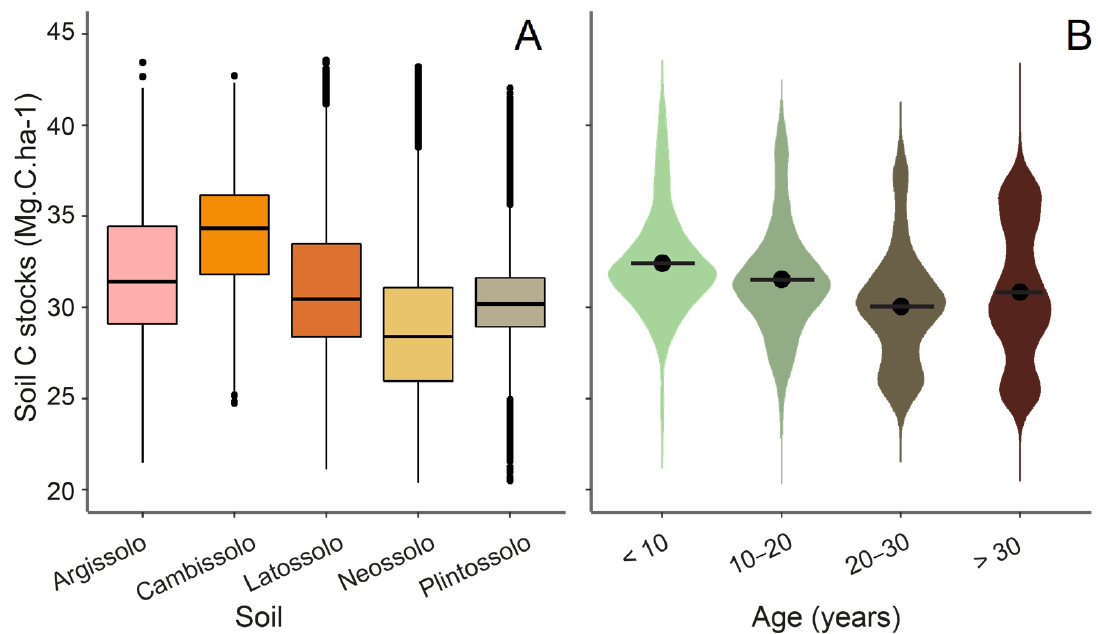
Figure 6. Estimated carbon stock for pasture areas of the Cerrado biome in the year 2019. ( A ) Carbon stock according to soil type. ( B ) Carbon stock according to pasture age (*3.0% of the area occupied by pastures in the biome belonged to unanalyzed soil orders).